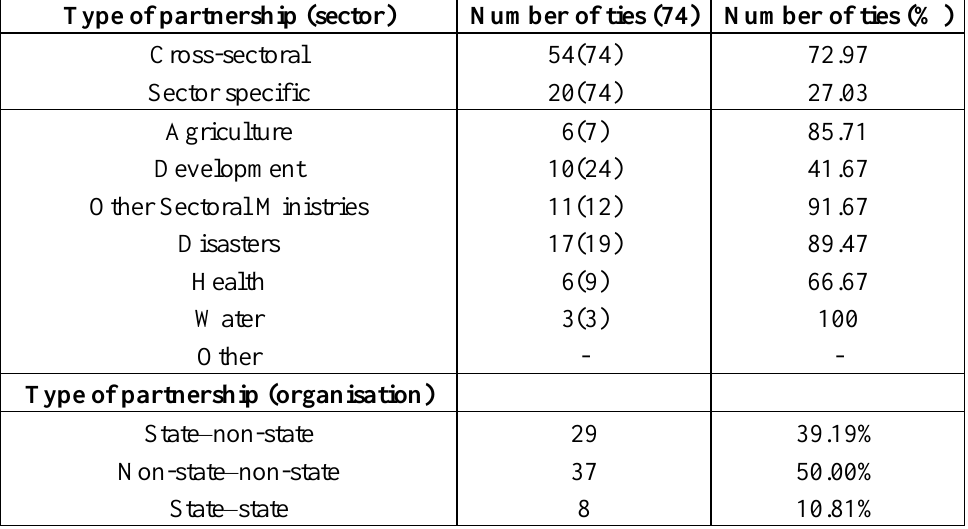
Table 11. Informal ties between different sectors and types of